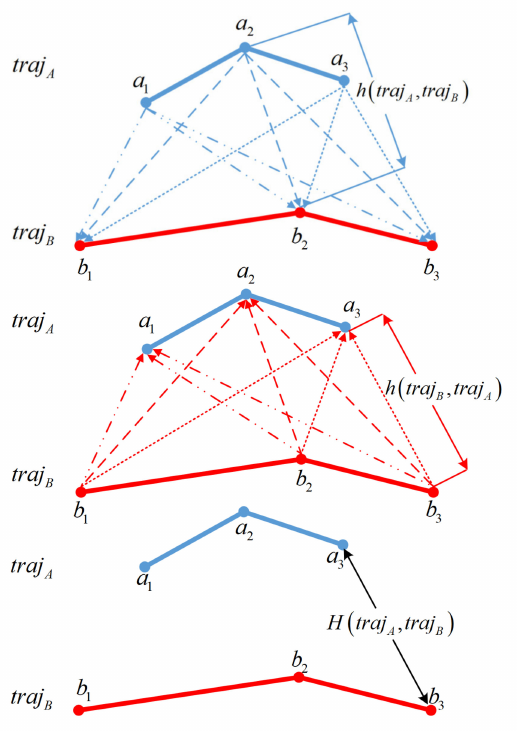
Figure 3. Principle diagram of Hausdorff